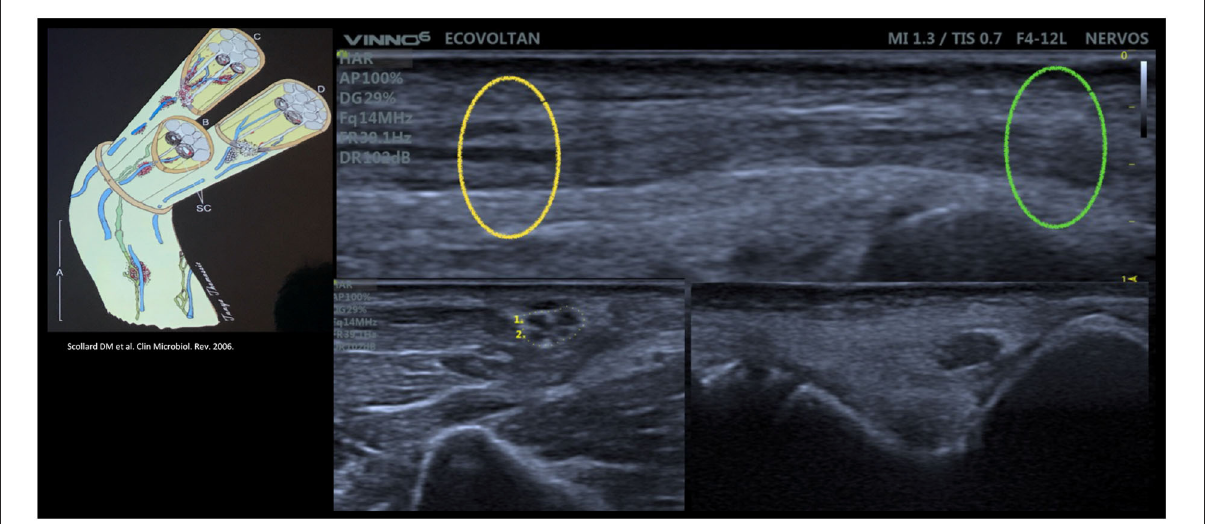
FIGURE8 Intraneural focality pattern [Scollard pattern (4) demonstrated by Voltan, G and Frade, MAC with the high-resolution ultrasound] of the ulnar nerve on the longitudinal view (up) and transversal view (down right and down left) showing the different fascicle patterns in the same nerve.